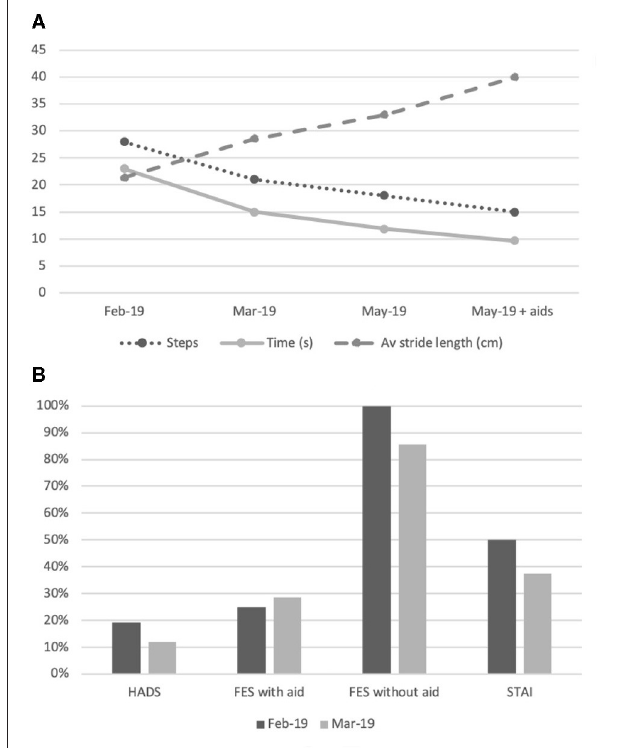
FIGURE 1 | Summary of gait assessments and subjective measurements. (A) Changes in step count, time (seconds) and average stride length (cm) for a 6-metre walk. Data obtained at three time points: February 2019, March 2019, and May 2019. Further data provided in May 2019 for 6m walk aided with a walking stick; (B) Subjective measures of anxiety and fear of falling with HADS, FES-I and STAI as a proportion of maximum possible scores at two time points: February 2019 and March